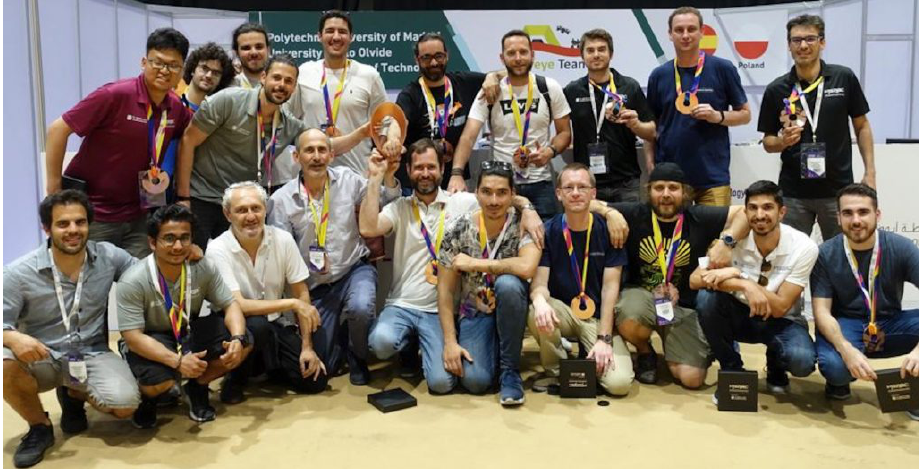
Figure 1. The Skyeye team award